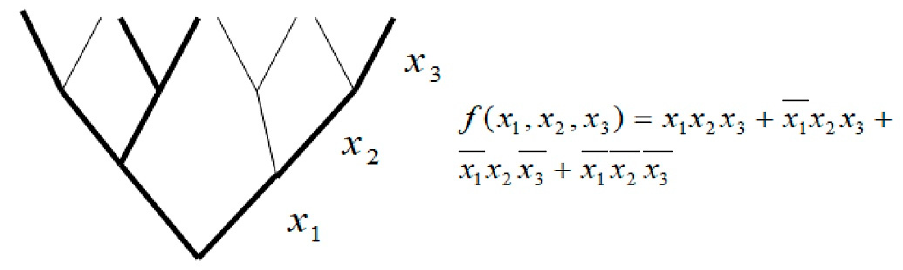
Figure 4. Boolean function of three variables encoded on a logic tree.